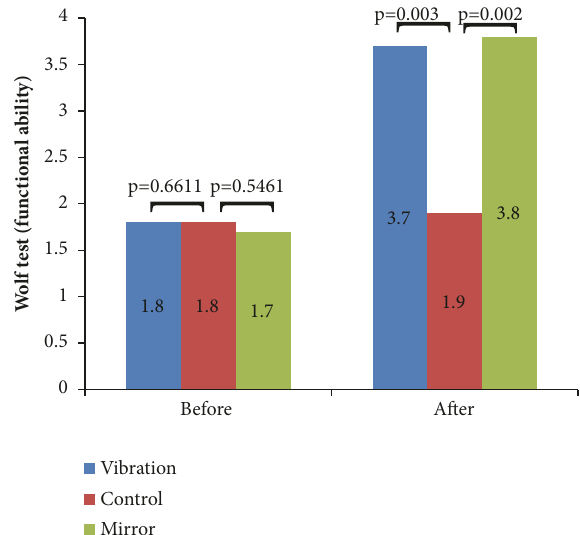
Figure 4: Comparative data of motor function of the Wolf Test (functional ability) of the control group, vibration and mirror therapy before and after the